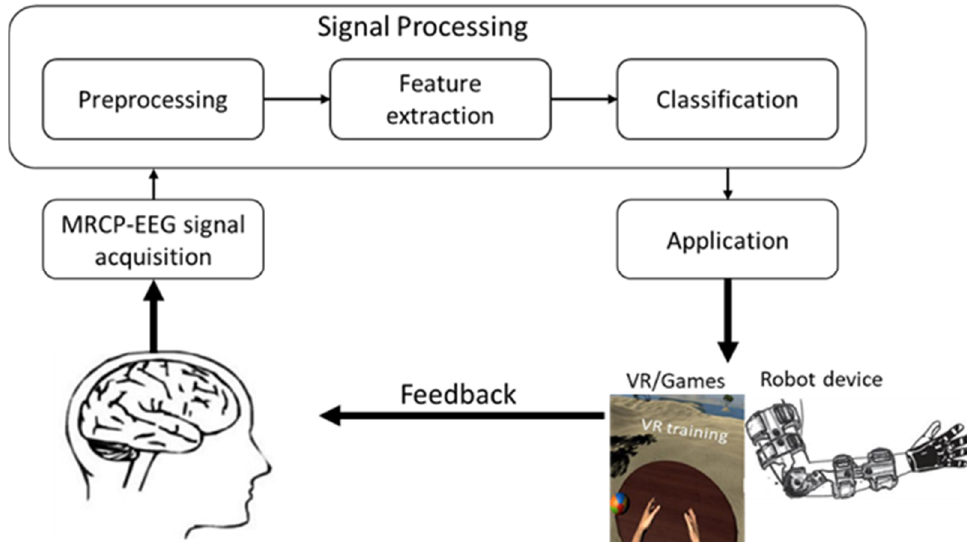
Figure 1. General schematic representation of RT and VR-MRCP-based BCI systems from signal acquisition and signal processing to application in either VR or RT. EEG-based BCI employs steady-state visual evoked potentials (SSVEPs), P300 event- related potentials, movement-related cortical potentials (MRCPs), and sensorimotor rhythms (SMRs) as different neuro mechanism types of EEG-based BCIs. Recent research has shown time-domain (LFTD) (0–5 Hz) [16–18] approximately 2 s earlier than the onset